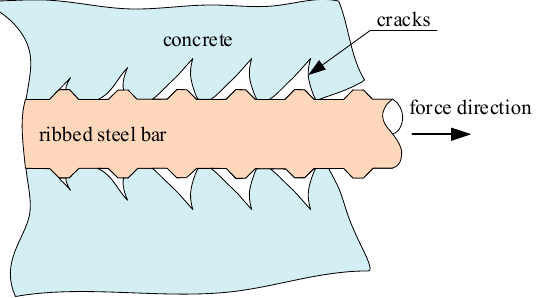
Figure 1. Distribution of cracks near the transverse ribs of ribbed steel bars under load. After the ribbed steel bars are subjected to a force, the surrounding concrete produces oblique extrusion force p on transverse ribs, as shown in Figure 2. In the figure, θ is the angle between the concrete sliding surface near the transverse ribs and the axis of ribbed steel bars, and µ is the friction coefficient between the ribbed steel bars and concrete. By decomposing the oblique extrusion force p and friction force µ p on the concrete sliding surface along the axis and radial directions of the ribbed steel bars, the bond stress τ and the radial pressure q 1 can be obtained, as written in Equations (1) and (2), respectively.